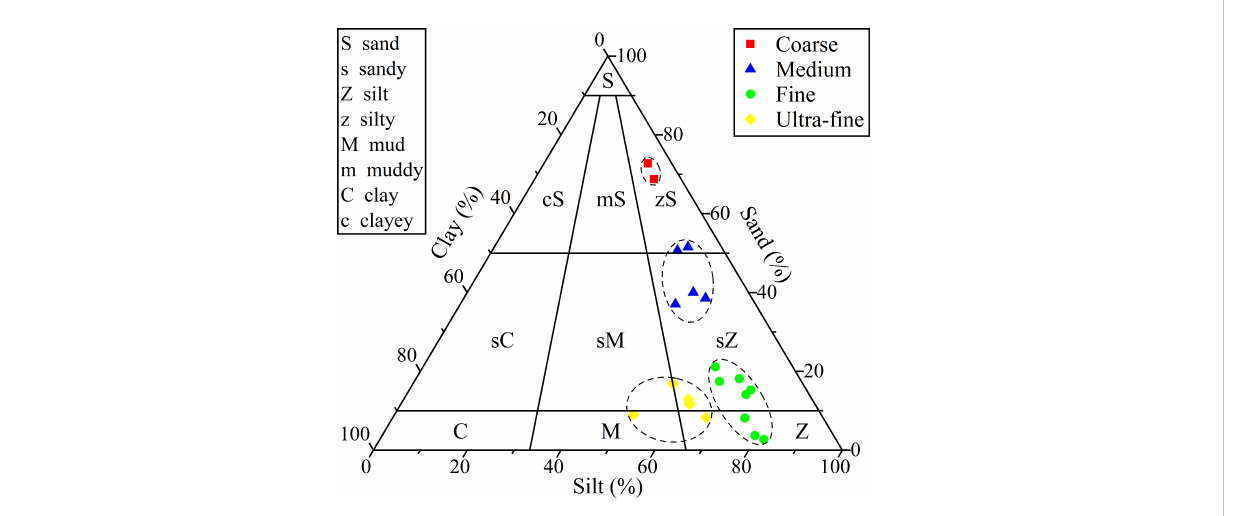
FIGURE 2 Classi fi cation of surface sediments in Prydz Bay and the adjacent Southern Ocean. Samples are classi fi ed into 4 categories based on a cluster analysis: “ Coarse ” (red squares), “ Medium ” (blue triangles), “ Fine ” (green dots) and “ Ultra- fi ne ” (yellow